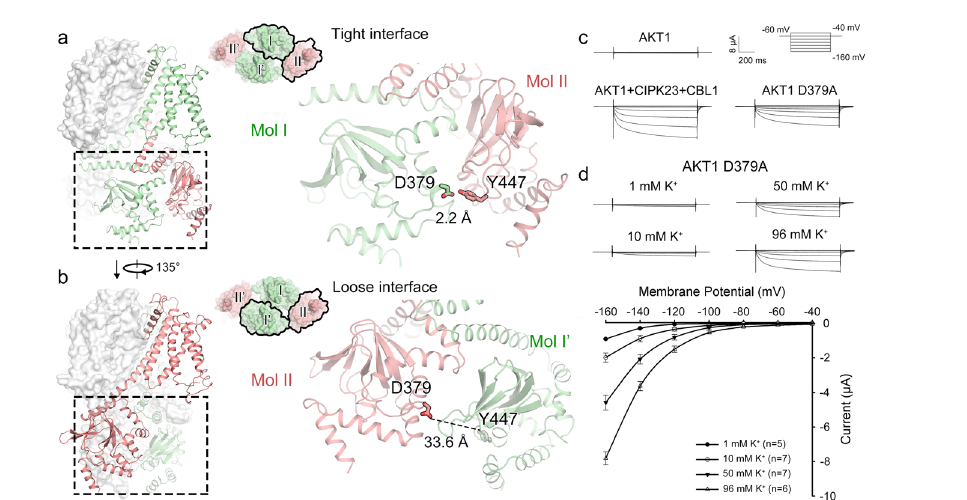
Fig.4|Identi fi cationofaconstitutively-activemutantbydisruptingthedimer interface. a , b Two different packing interfaces of AKT1. The boxed regions are enlargedintherightpanels.Asp379andTyr447areH-bondedatthetightinterface. The distance between Asp379 and Tyr447 is 33.6Å at the loose interface. c , d Whole-cell currents and I-V curve of a constitutively-active mutant Asp379Ala